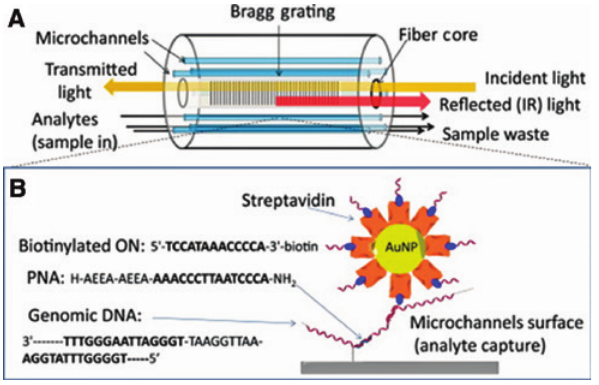
Figure 9: Scheme of the biosensor based on a microstructured fiber with an FBG (A). Scheme of the assay based on the capture of the target genomic DNA by the immobilized PNA probe and the subse- quent detection, thanks to the formation of a sandwich with another DNA probe fixed onto AuNPs